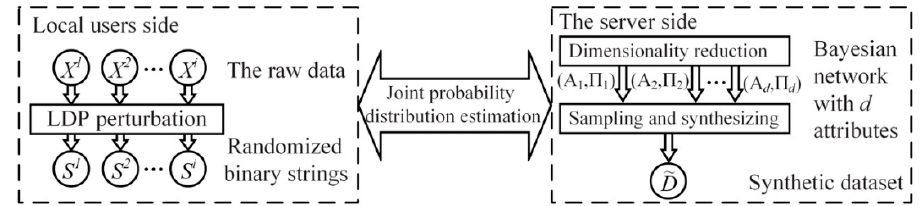
Figure 3. The overview of the local protection on high-dimensional data.